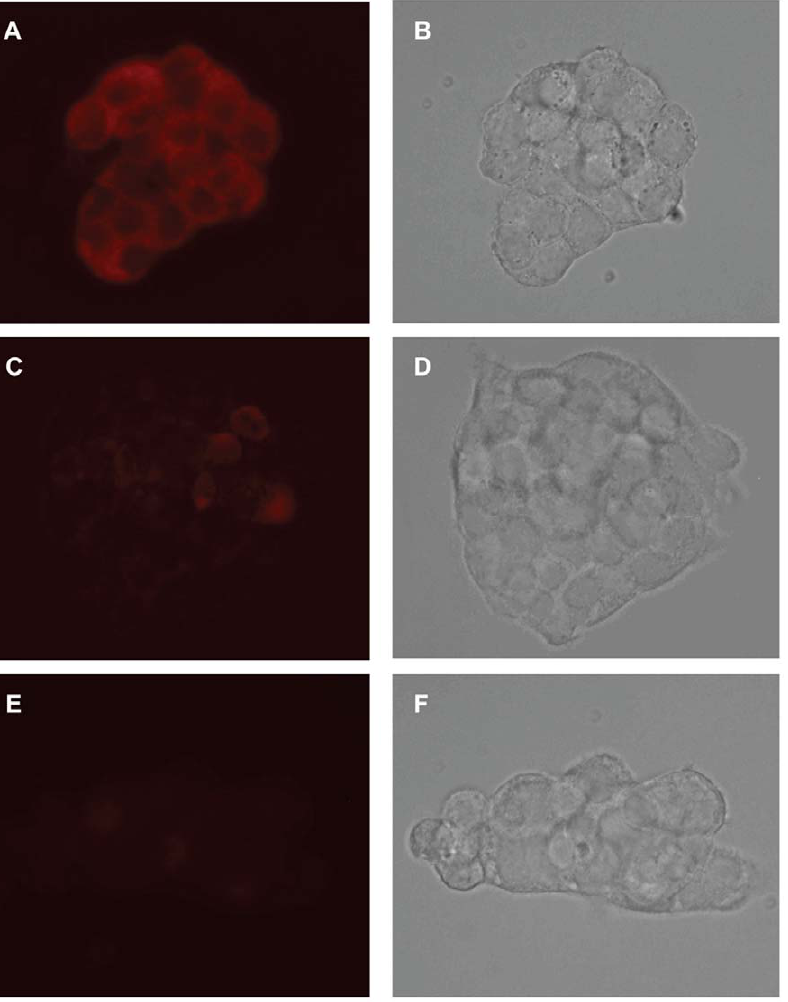
Figure 7. Immunolocalization of Epac 1 and Epac 2 in 16HBE14o- cells. With the use of specific antibodies, immunofluorescence staining of Epac 1 (A) and Epac 2 (C) were localized to the cytoplasm of 16HBE14o- cells, as indicated by the red colour. Under the conditions specified in the Methods section, the signal intensity of Epac 1 was stronger than that of Epac 2, which may suggest a higher and more uniform expression of Epac 1 in these cells. In the negative control (E), omission of the primary antibodies resulted in a complete loss of the immunofluorescence. The corresponding images taken in brightfield were shown in B, D and F.